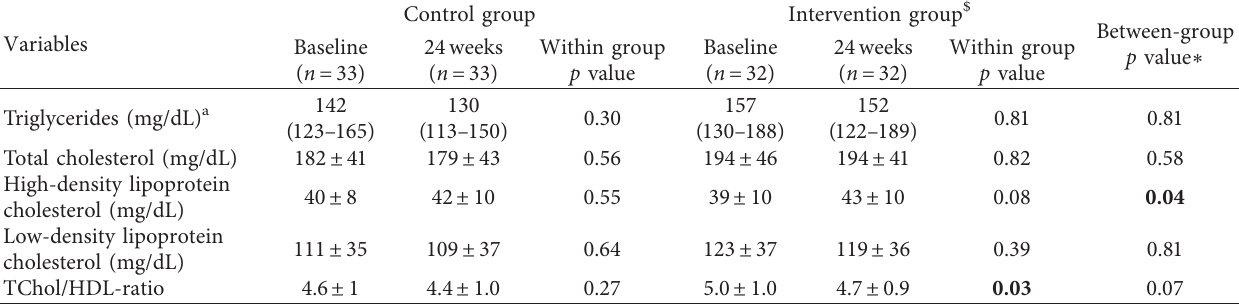
Table 4: Change in blood lipid levels of control and intervention groups over 24 weeks based on intent to treat ( n � 65).